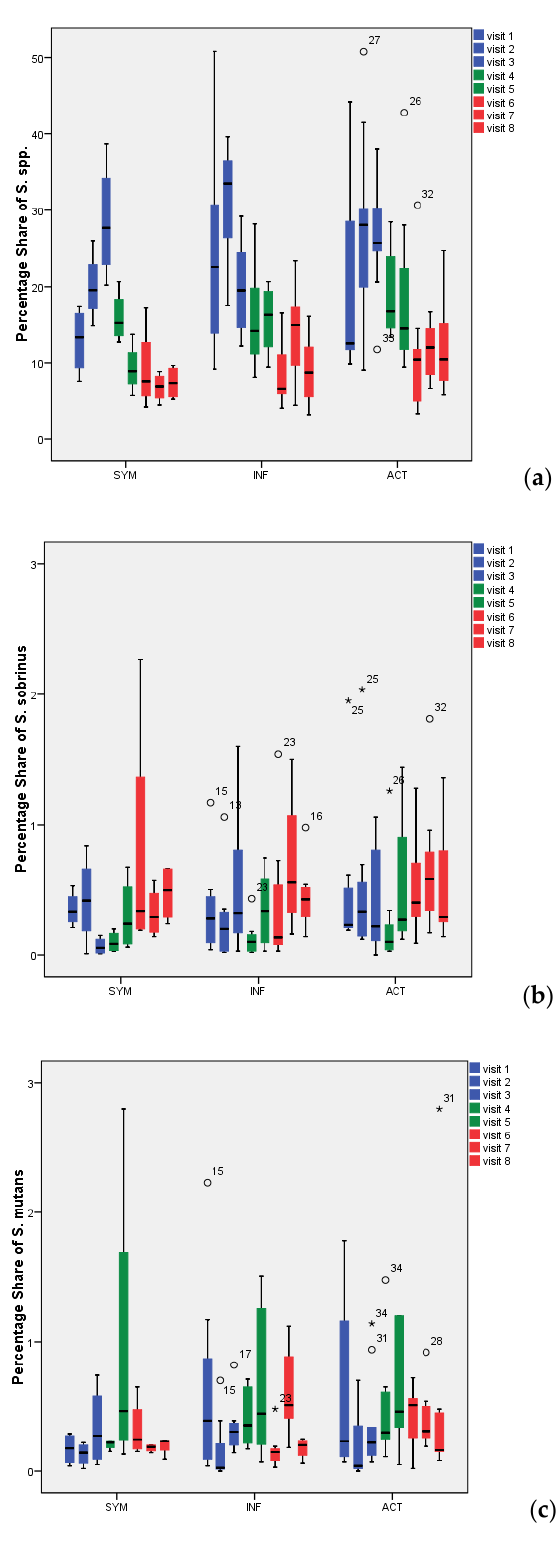
Figure 3. Percentage of all Streptococcus spp. ( a ), Streptococcus sobrinus ( b ), and Streptococcus mutans ( c ) in 72-h dental biofilm. °: Outliers with values between 1.5 and 3 times the interquartile range (IQR) above the 75%-quantile (Q3) (Q3 + 1.5 × IQR ≤ value ≤ Q3 + 3 × IQR); *: Extremes with values more than 3 times the IQR higher than Q3 (value > Q3 + 3 × IQR).